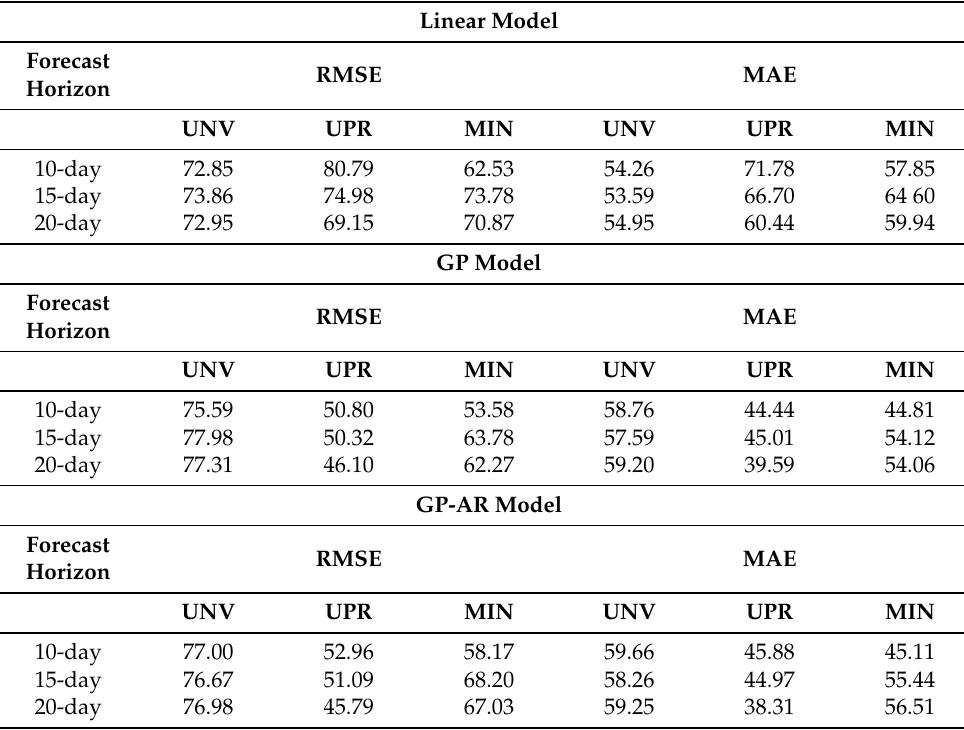
Table 9. Accuracy evaluations for three forecast horizons using validation set UNV, UPR and